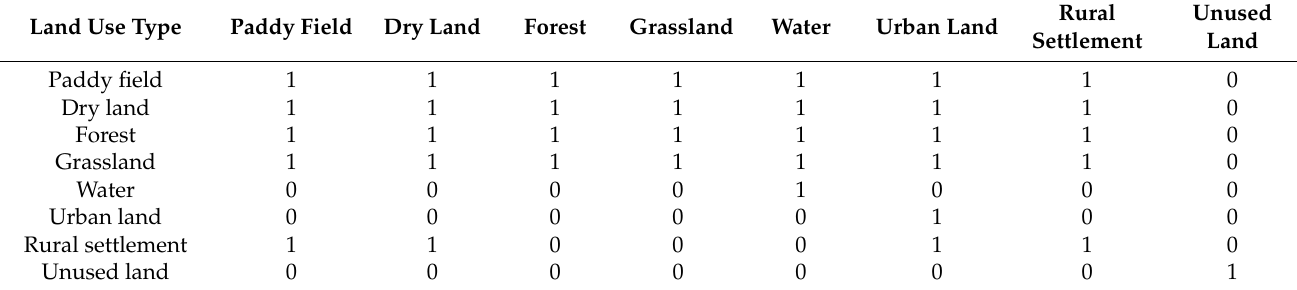
Table A5. Land use conversion cost matrix of REC